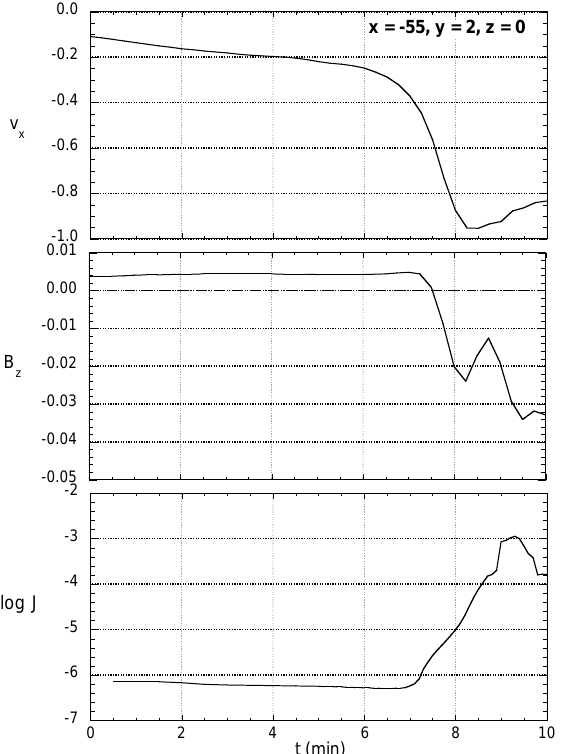
Fig. 11. Temporal evolution of characteristic parameters at x =− 55 ,y = 2 ,z = 0; (top) plasma velocity component v x , (center) magnetic field component B z , and (bottom) 180 keV tailward O + fluxes. The fluxes are calculated using initial kappa distributions (see text). At t ≈ 7 . 5 B z turns negative, showing the passage of the o-line in the center of the plasmoid; see also Figure 1. At about the same time the tailward flow speed and the O + flux